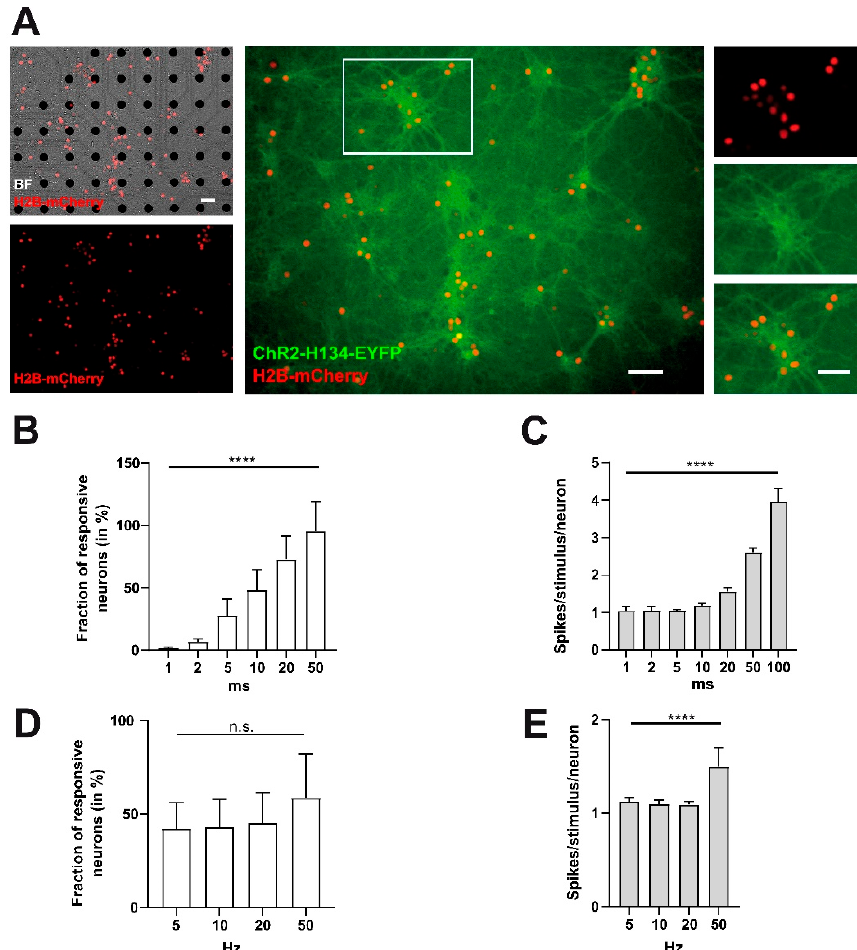
Figure 4. LED-based illumination of genetically modified cortical neurons on MEA allows optogenetic stimulation with physiological stimulus parameters. ( A ) Example culture of ChR2- and H2BmCherry positive neurons at the start of recording and stimulation (DIV14). Note that most neurons are co-transduced with both transgenes. ( B ) Effect of the pulse duration of optogenetic stimulation on extracellular responses of cortical cultures recorded by MEAs. The relative fraction of responding neurons increased with increasing pulse duration ( n = 7 cultures; p < 0.0001). ( C ) In the responding neurons, mainly a single action potential was induced at stimulus durations ≤ 10 ms ( p < 0.00001). ( D , E ) Effect of stimulus frequency using a pulse duration of 10 ms on the relative fraction of responding neurons ( D ) and the number of spikes per responding neurons ( E ). Note, neurons can follow the test stimuli with a frequency of up to 50 Hz. Scale bars represent 50 µm. Data points indicate the mean ± SEM and **** indicates p -value of <0.0001, respectively.